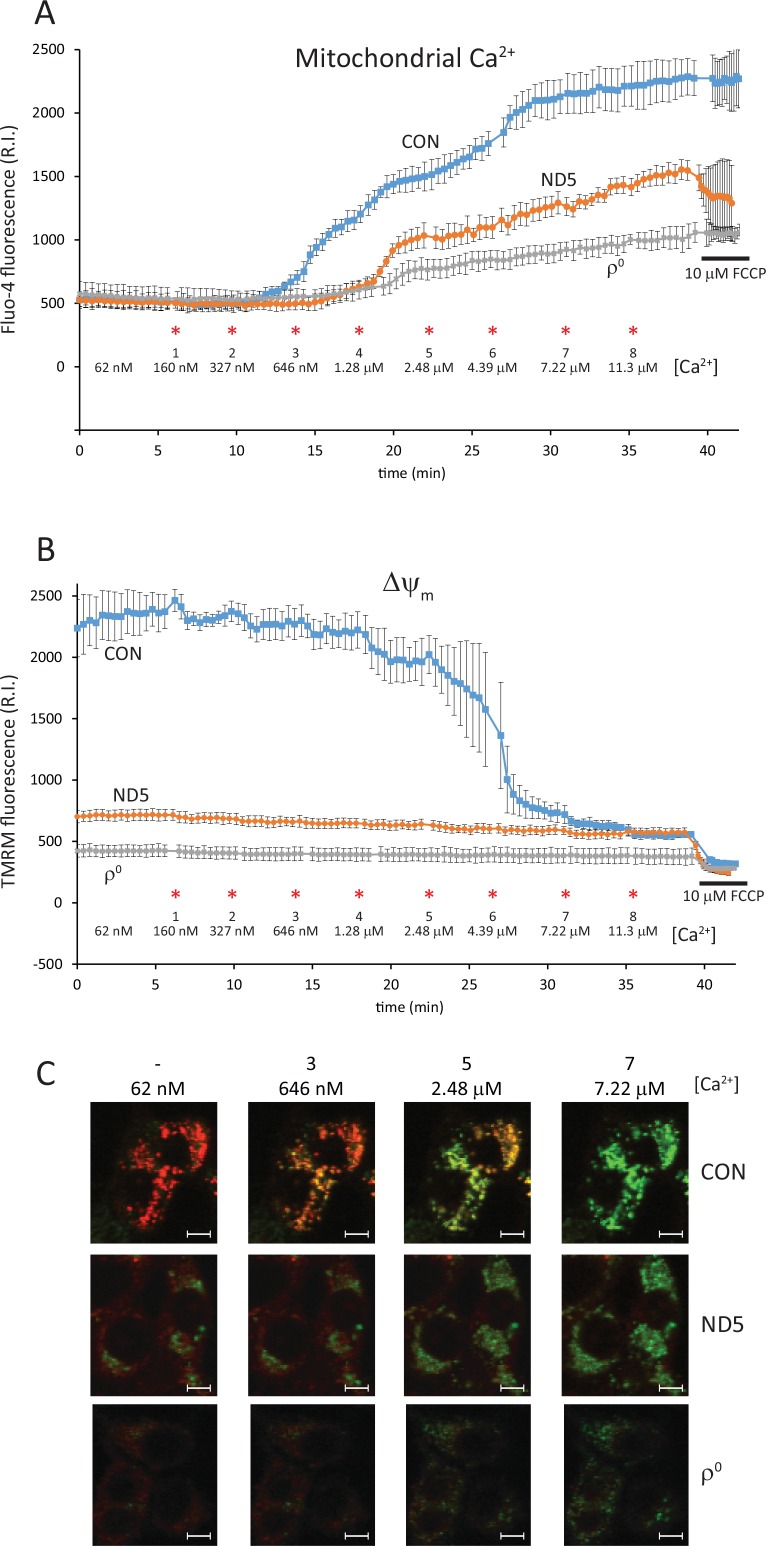
ND5 mutant mitochondria have a reduced ability to buffer calcium.Mitochondrial calcium [Ca2+]m (A) and Δψm (B) were measured concurrently by confocal microscopy using fluo-4 and TMRM in digitonin permeabilized cells. Exogenous calcium was added in sequential aliquots at the concentrations and times indicated (*). Control (CON) cybrid mitochondria were able to buffer more calcium than both ND5 mutant cybrid mitochondria and ρ0 cell mitochondria. Increases in [Ca2+] up to 2.48 μM were buffered by CON cybrid mitochondria, with a step-wise decrease (followed by recovery) of Δψm evident. Δψm was lower in both ND5 mutant cybrids and ρ0 cells, and was not affected by increases in [Ca2+]. (C) Confocal images of CON cybrids, ND5 mutant cybrids and ρ0 cells showing the simultaneous staining of [Ca2+]m (fluo-4, green) and Δψm (TMRM, red). The number of the calcium aliquot and the [Ca2+] are indicated. Data is mean ± s.d. n = 3.White scale bars = 10 μm.